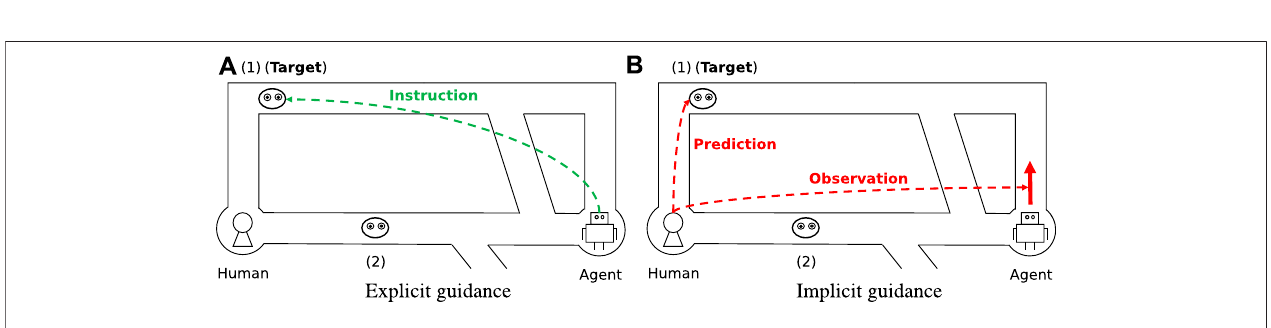
FIGURE 2 | Example of agent with